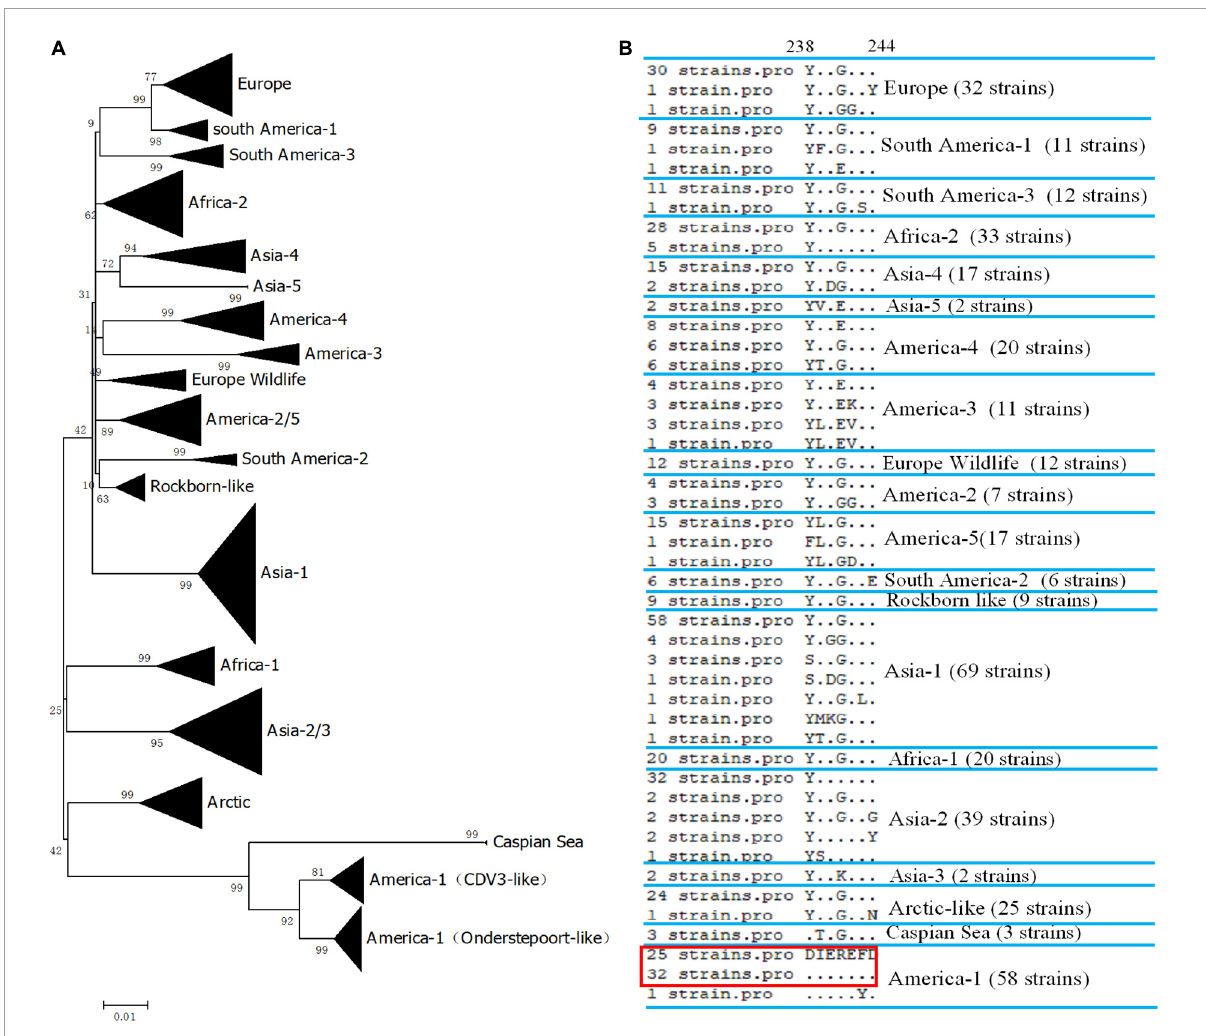
FIGURE4 Conservative analysis of antigen epitope. (A) Phylogenetic relationships based on the H genes of 405 canine distemper virus (CDV) strains. Distance values were calculated by the Clustal W program using the MEGA 6.0 software package. The tree was constructed by the Maximum-Likelihood method, and bootstrap values were calculated on 1,000 replicates. (B) Alignment of amino acids sequence of the neutralizing epitope in different lineages of CDV strains. The dots indicated the same amino acids with the epitope 238DIEREFD244 in red